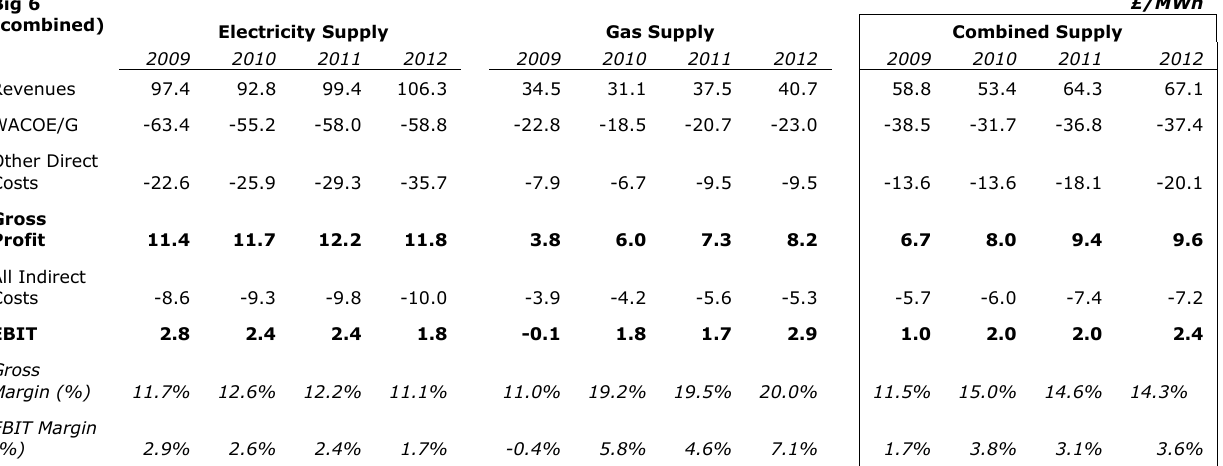
Figure 45: Combined Unit Revenues and Unit Costs (£ per MWh) and